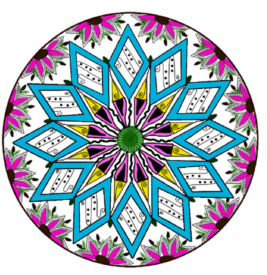
Figure 1. Image formed by a typical